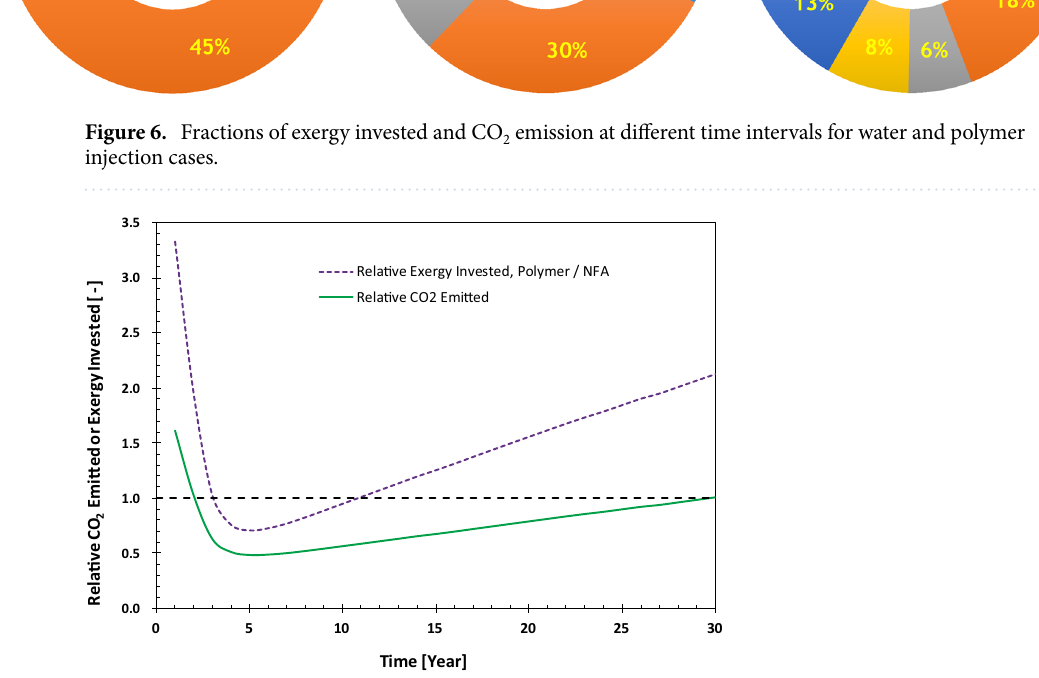
Figure 7. History of relative exergy invested and CO 2 emitted for field A in the Middle East. The calculations are based on simulation results. NFA stands for no further action, i.e., production by natural aquifer